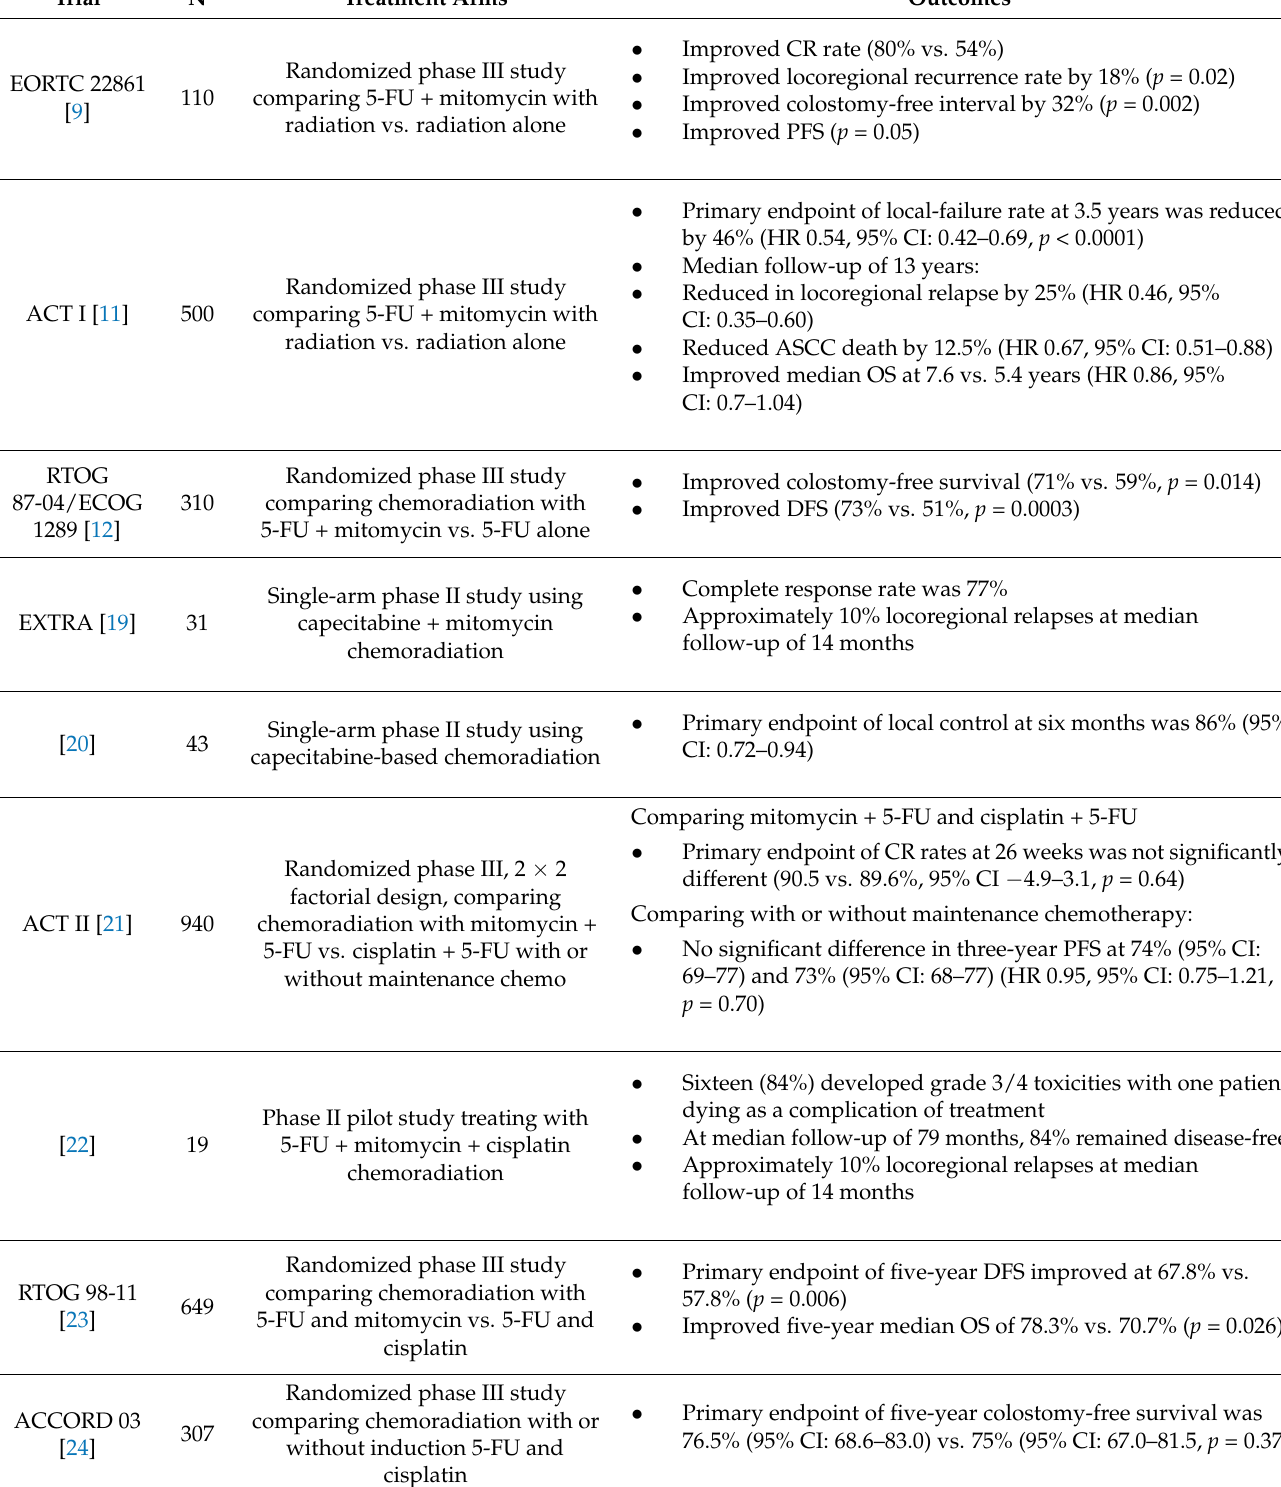
Table 1. Landmark studies in management of locoregional